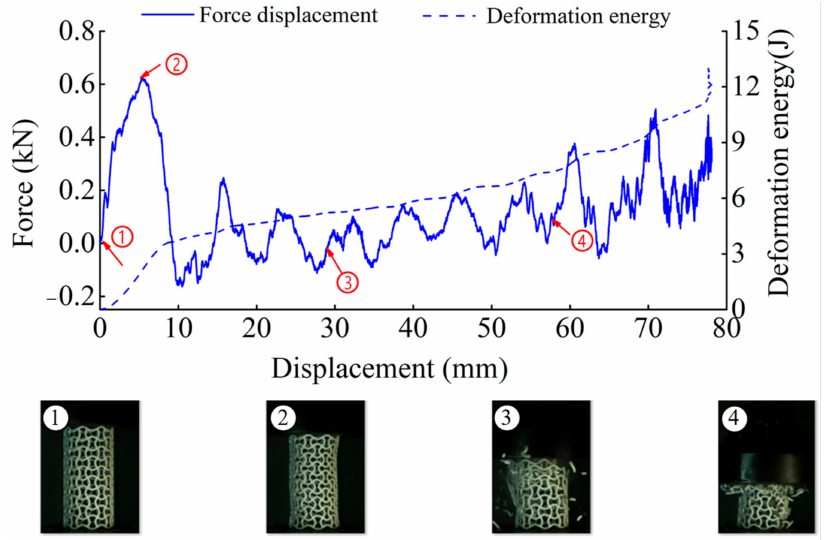
Figure 17. The results of dynamic tests of CCHT2 (1–4 stages of deformation during the dynamic compressive test).